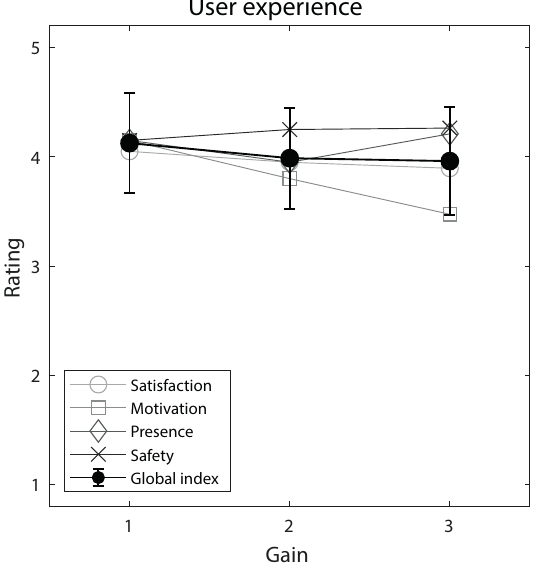
Figure 4. User experience, as assessed through the global index, across the three gain levels. The global index was computed by averaging, for each participant, the satisfaction, motivation, sense of presence, and sense of safety ratings (open symbols, range 1–5). Gain 1 is the natural visuomotor gain, whereas gains 2 and 3 implement two-fold and three-fold augmented gaze, respectively. Error bars are 99% confidence intervals of the